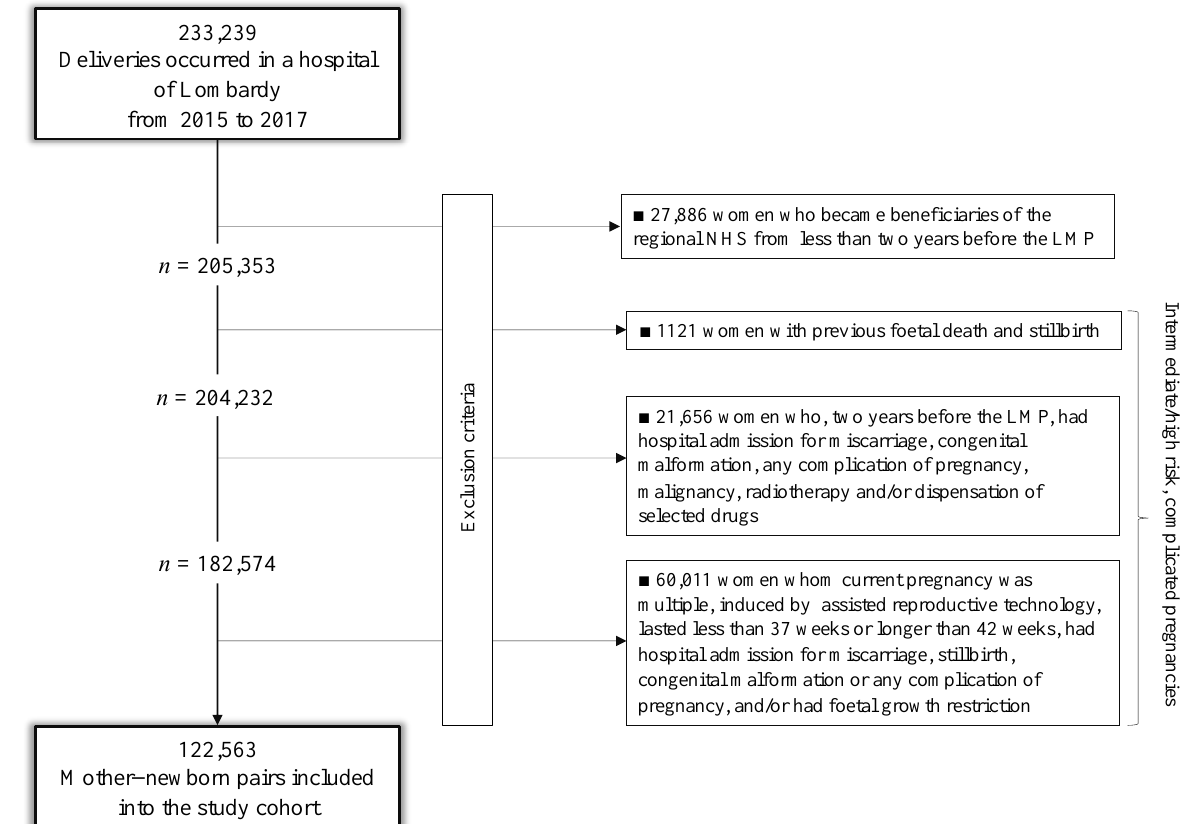
Figure 1. Flow-chart of inclusion and exclusion criteria.